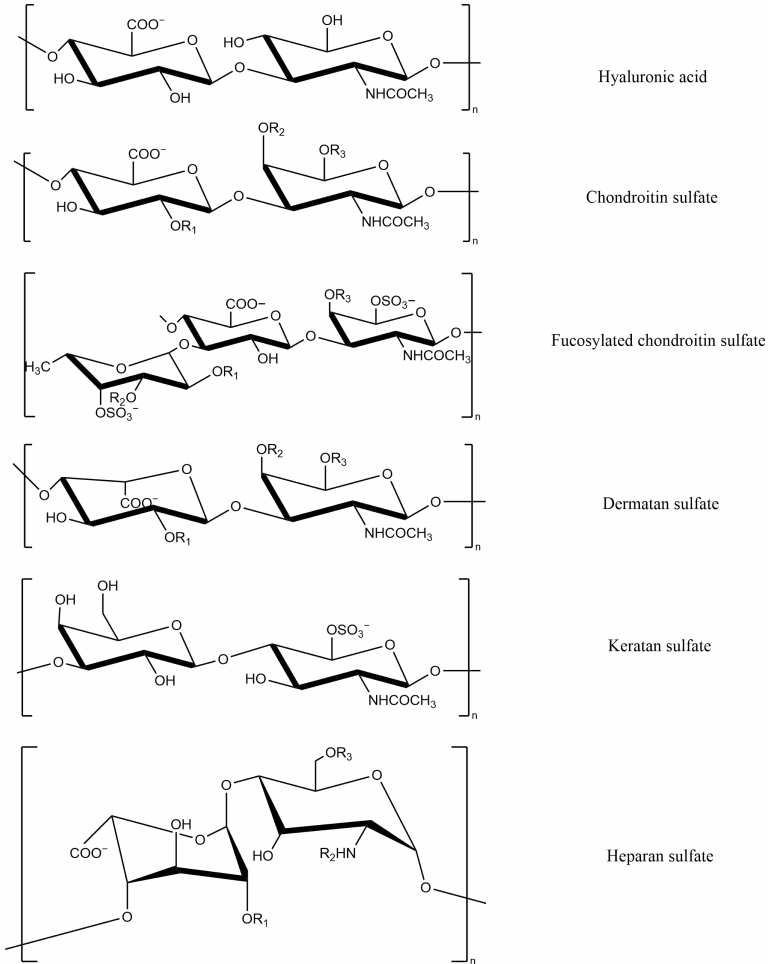
Figure 5. Chemical structures of common GAGs